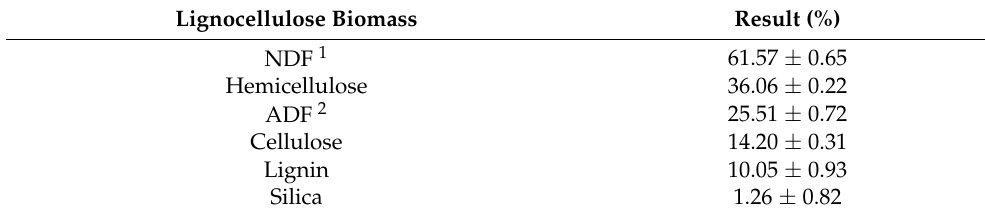
Table 1. Composition of Lignocellulosic Content of Pineapple Cores.